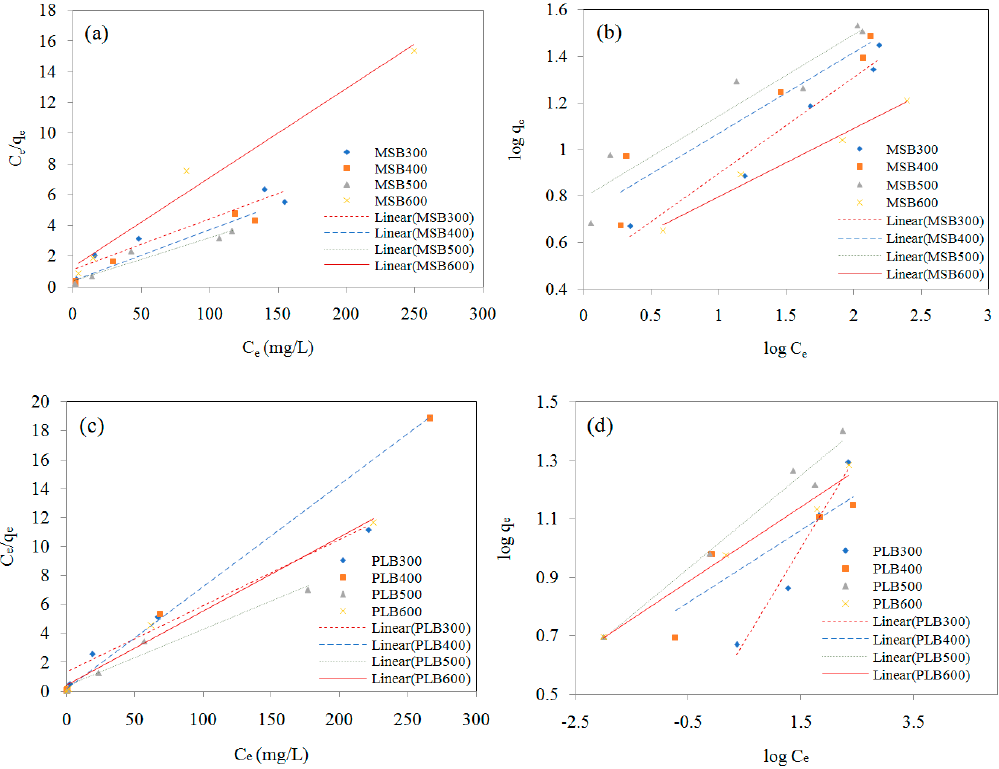
Figure 7. The linear Langmuir (( a ) (MSB), ( c ) (PLB)) and Freundlich (( b ) (MSB), ( d ) (PLB)) isotherms of Cd on MSB and PLB from different pyrolytic temperatures at pH 4.5–5.0. Table 2. The parameters of the Langmuir and Freundlich isotherm models. Langmuir Freundlich Adsorbent q max (mg/g)